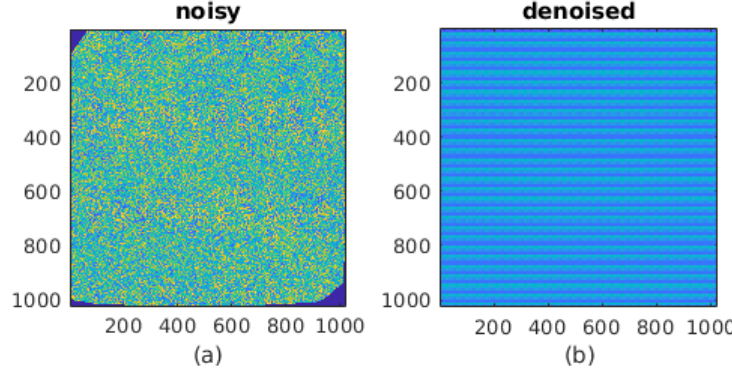
Figure 7. ( a ) The CARSCAN extracted terrain field τ ( x , z ) ∼ N ( 2.5,1.0 ) from the original Gaussian hill profile data as in Figure 5. ( b ) The subsequent denoising of ( a ) using the Burger multilayer perceptron (MLP) [22].